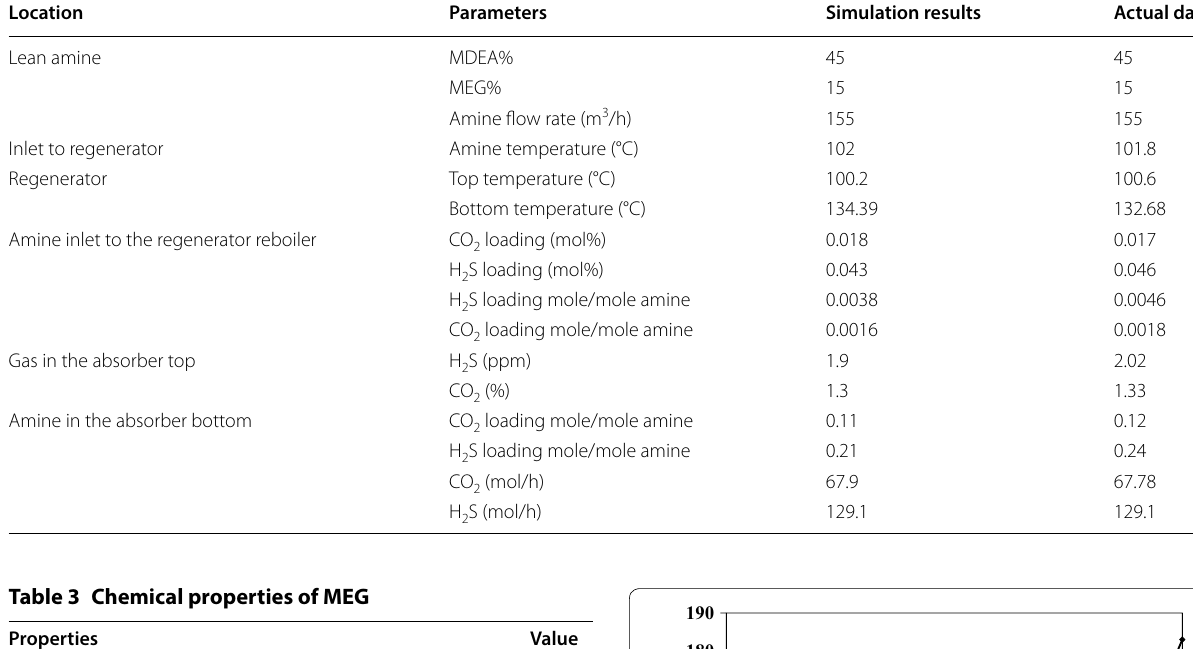
Table 2 The comparison of the simulation results of the gas sweetening unit with Promax with actual data Location